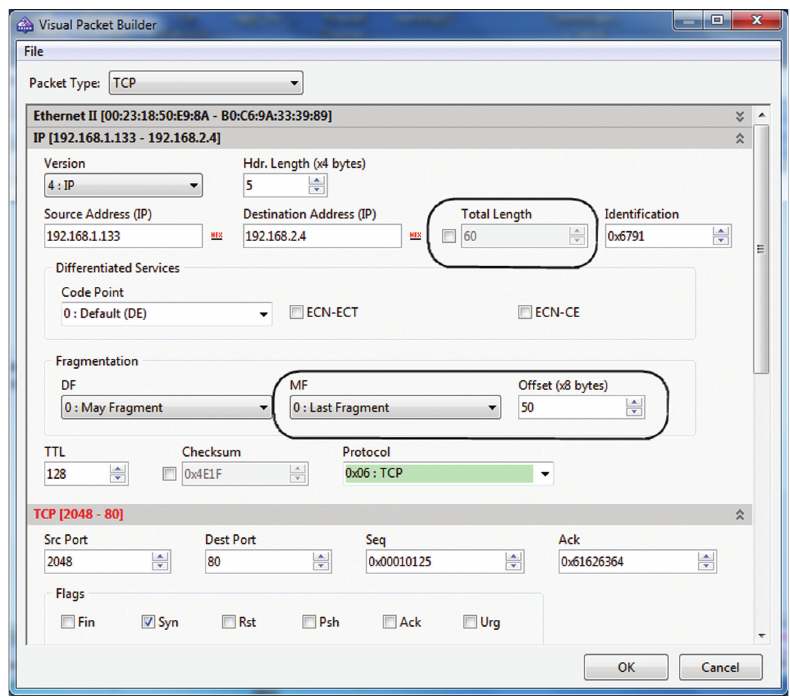
have overlapping offset